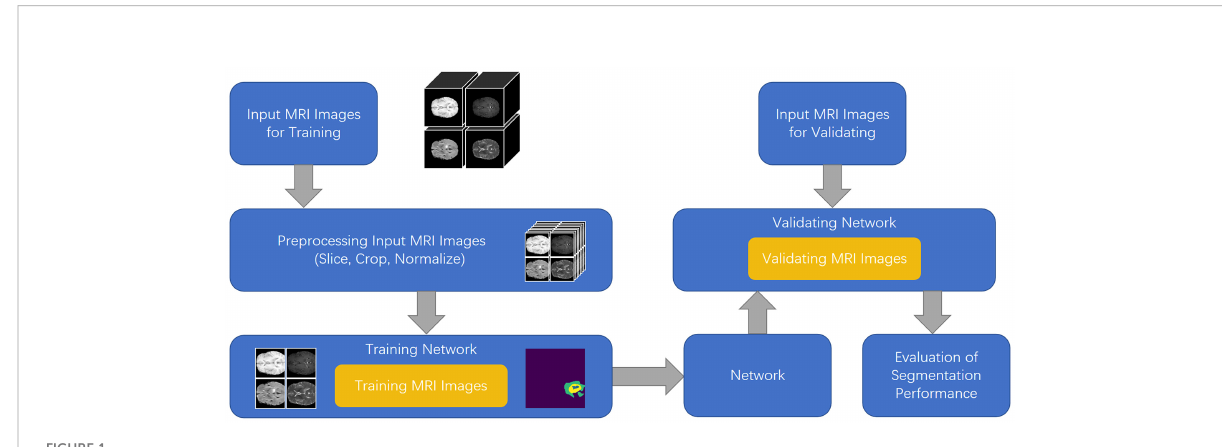
FIGURE 1 Illustration of brain tumor segmentation pipeline for